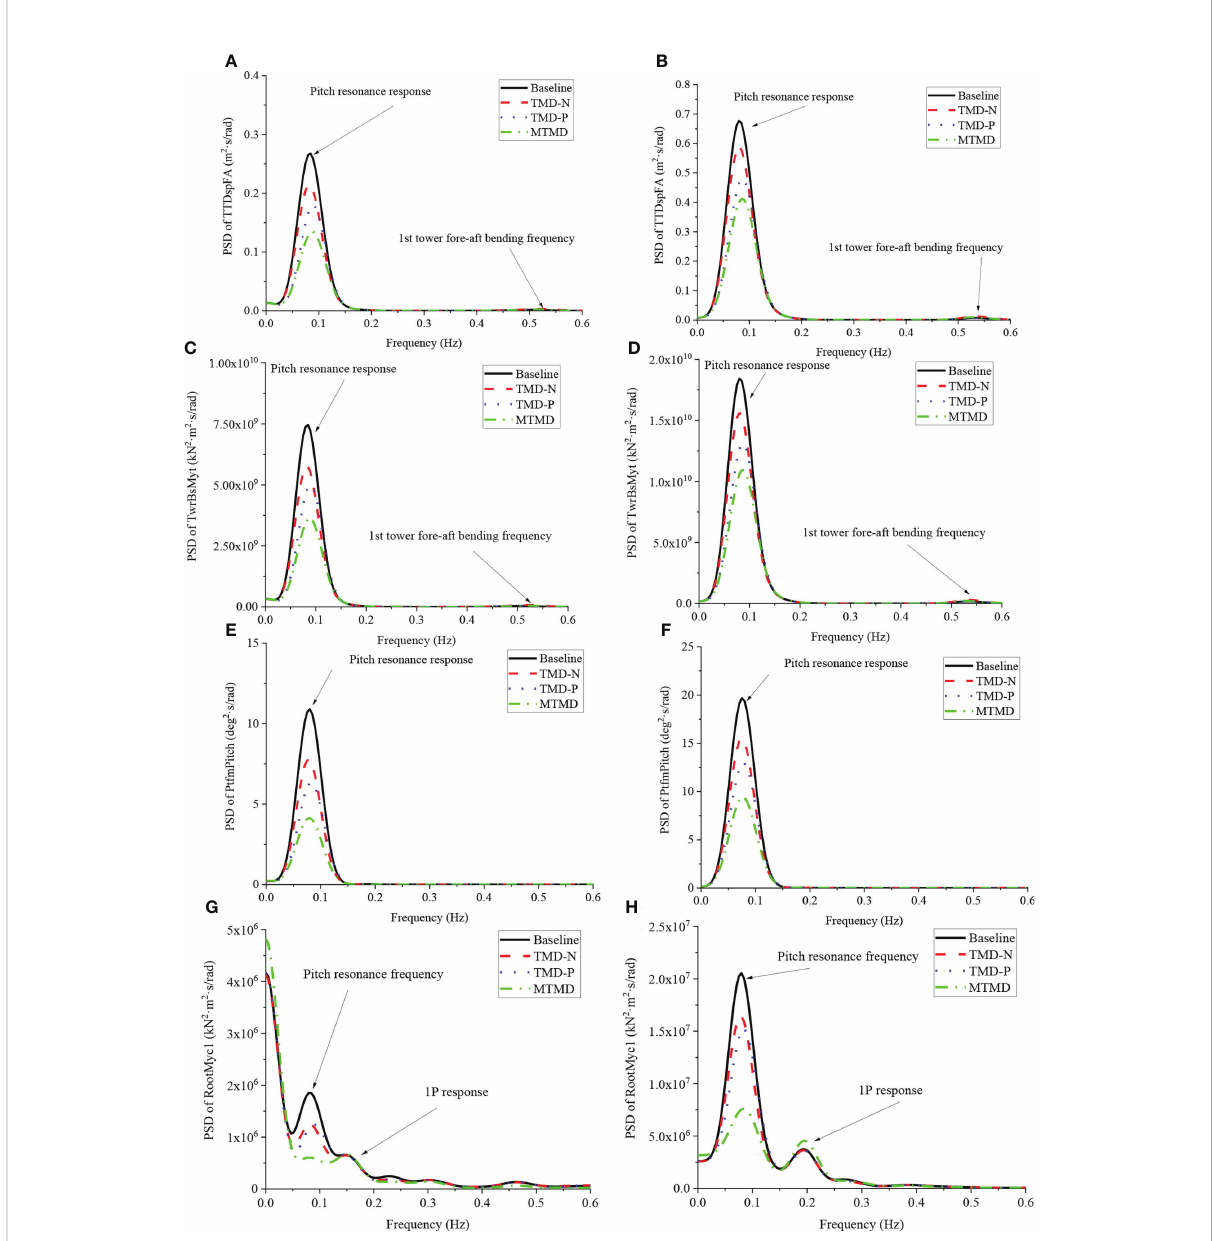
FIGURE 11 Reduced PSDs of the barge FOWT motions under typical wind and wave conditions using the optimized TMDs and MTMD. (A) PSD of tower top displacement under load case 2; (B) PSD of tower top displacement under load case 4; (C) PSD of tower base bending moment under load case 2; (D) PSD of tower base bending moment under load case 4; (E) PSD of platform pitch motion under load case 2; (F) PSD of platform pitch motion under load case 4; (G) PSD of fl apwise bending moment at blade root under load case 2; (H) PSD of fl apwise bending moment at blade root under load case